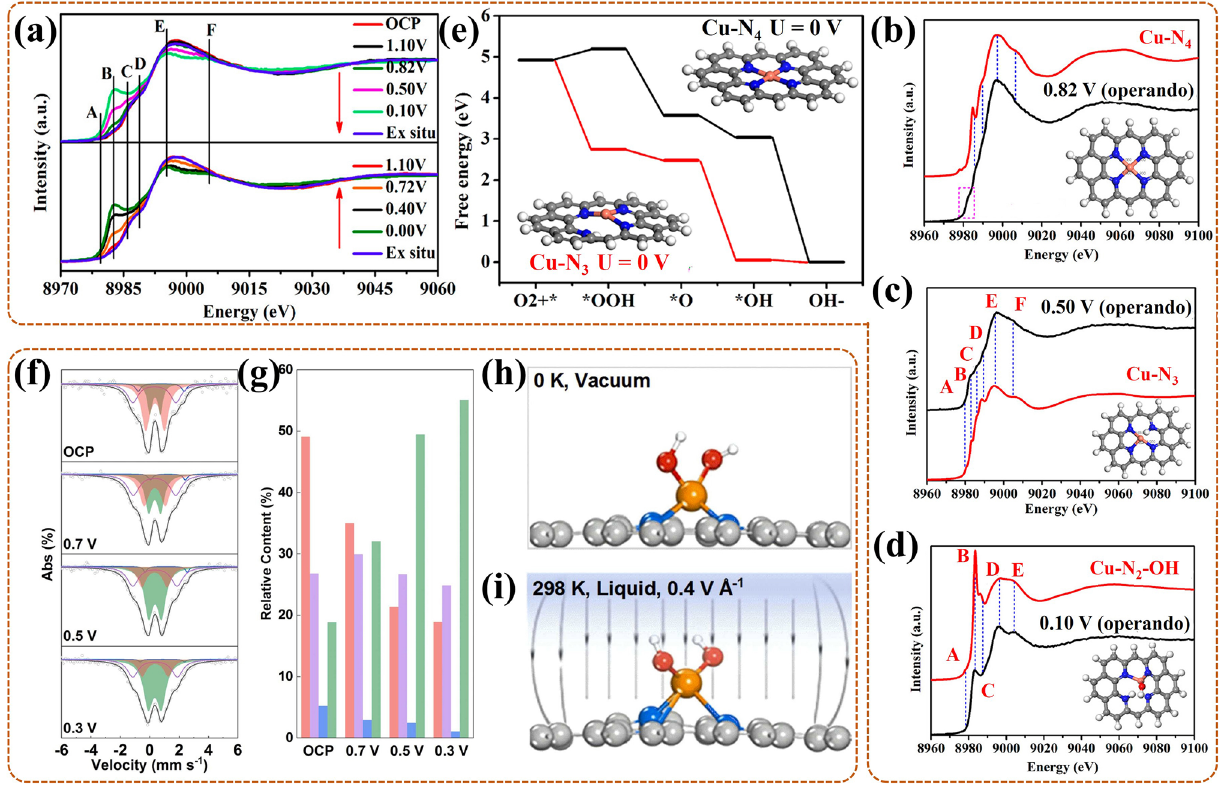
Fig. 15 a In-situ XANES spectra of Cu K-edge for Cu–N–C SAC catalyst in the cathode (top) and anode (bottom) at different potentials; The selecting XANES spectra at b 0.82 V, c 0.50 V, d 0.10 V, with theoretical Cu–N 4 , Cu–N 3 , Cu–N 2 –OH as comparison, respectively, also with each model in each right bottom inset; e At U = 0 V, the Gibbs Free Energy plots of each ORR steps on Cu–N 4 and Cu–N 3 sites [138]; Reused with approval; Copyright 2021 American Chemical Society. f In-situ Mössbauer spectroscopy of the 57 Fe–N–C at various potentials and g the matching relative content of D1, D2, D3, D4 for FeN 4 ; The AIMD simulations for the average bond distance in FeN 4 C 8 * 2OH at h 0 K, vac- uum, i 298 K, electrolyte, electric field of 0.4 V Å −1 [143]. Reused with approval; Copyright 2022